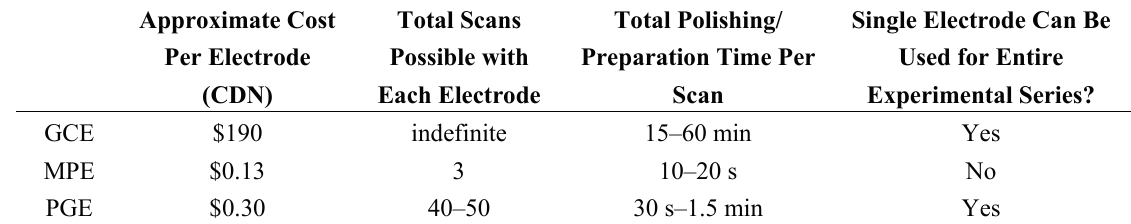
Table 4 Qualitative comparison of GCEs, MPEs and